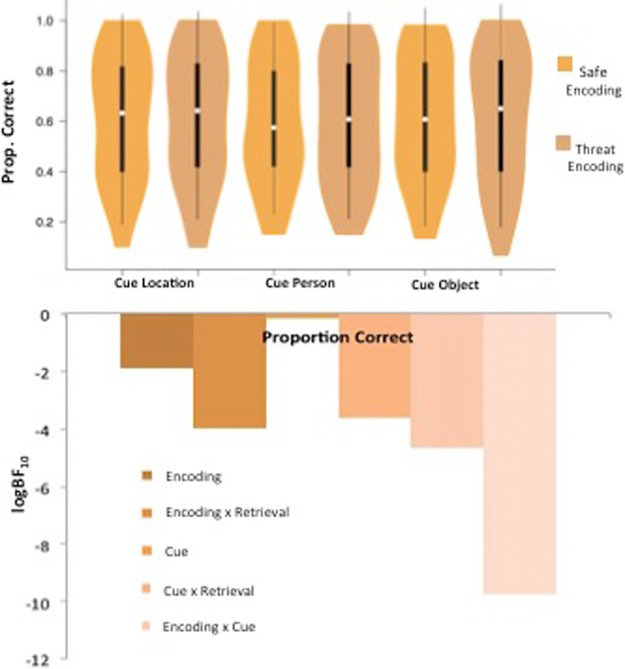
Associative memory task results. Violin plots displaying and proportion correct for each condition, and bar charts representing the Bayesian model evidence for proportion correct for each condition.